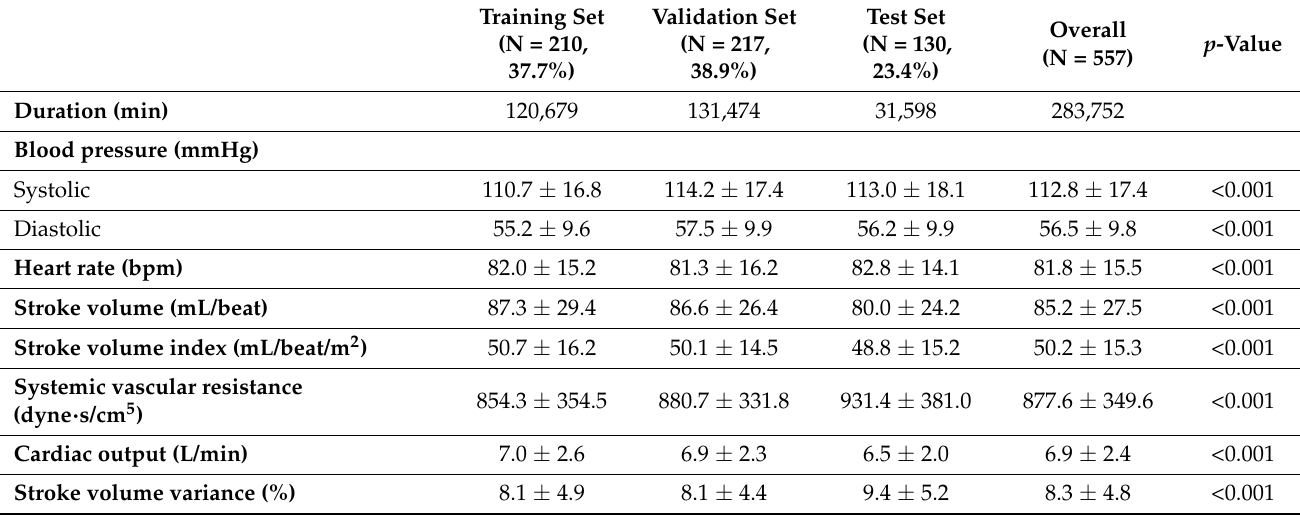
Table 2. Hemodynamic variable of training, validation, and test